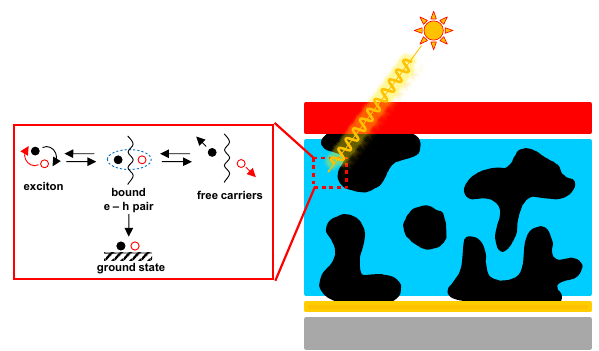
Figure 6b. Schematic of bulk heterojunction (BHJ) structure and charge generation process in OPV devices. An incident photon generates a coupled electron-hole pair (exciton) which diffuses to a donor (polymer) – acceptor (fullerene) interface to form a bound electron-hole pair. This bound state can then either recombine or separate into free charge carriers to generate a